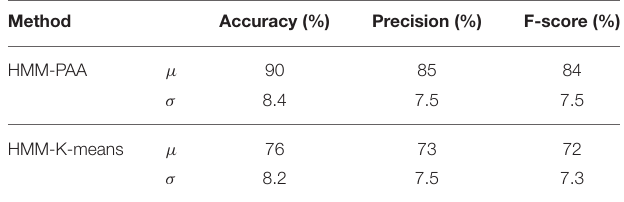
TABLE 2 | Confusion matrix of model 2 for Peg 2 with clearance c = 0.17 mm .